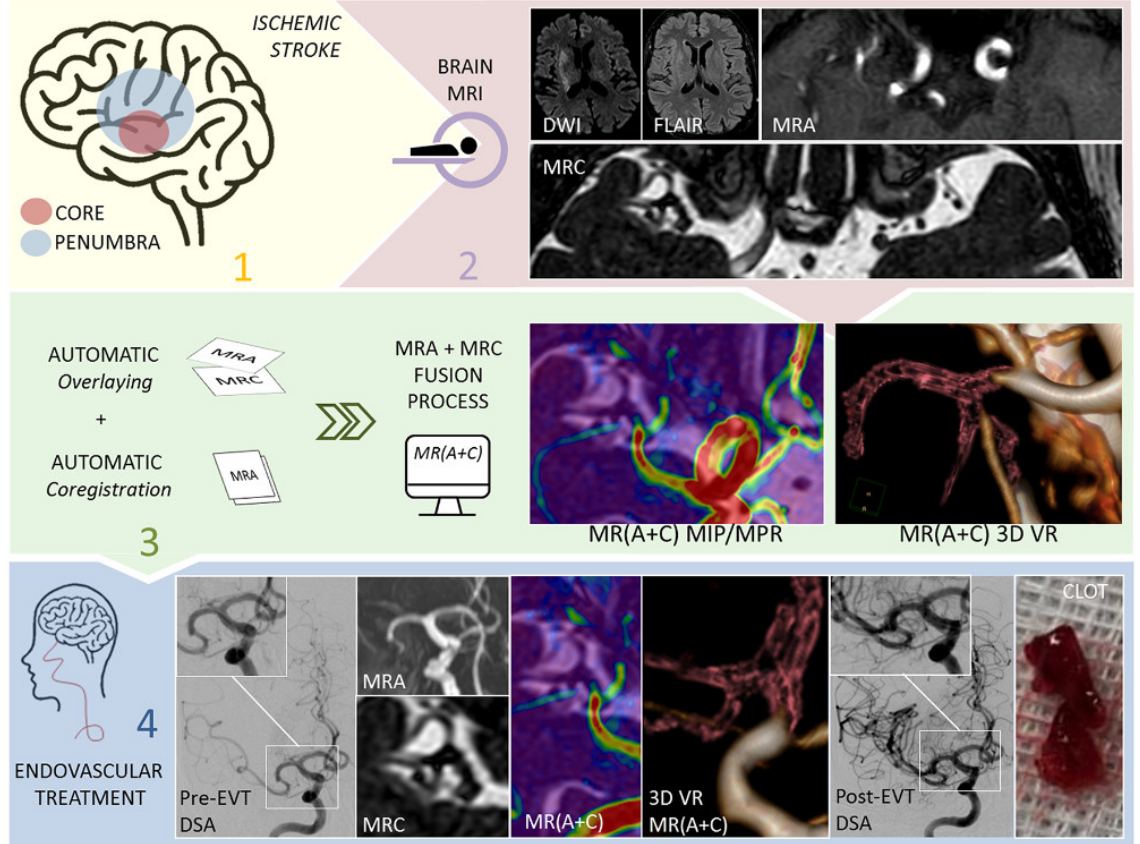
Figure 6. This figure shows the role that magnetic resonance cisternography (MRC) and magnetic resonance angiography (MRA), obtained with 3D CISS and 3D TOF, respectively, play in the diagnostic and therapeutic workflow in the setting of acute ischemic stroke (Mormina et al. [51,52]). This image was released under CC BY-NC-ND license (http://creativecommons.org/licenses/bync-nd/4.0/, accessed on 19 November 2022). 1 Clinical recognition of an acute ischemic stroke. 2 Brain MRI with the sequences diffusion-weighted imaging (DWI), fluid-attenuated inversion recovery (FLAIR), MRA and MRC. 3 Fusion process with the automatic overlaying and co-registration generates in a few seconds MR (A + C) fused images, with MIP, multiparametric (MPR) and volume-rendered (VR) reconstructions. 4 Endovascular treatment is performed on the patient affected by the acute ischemic stroke, with MR (A + C) serving as guidance.